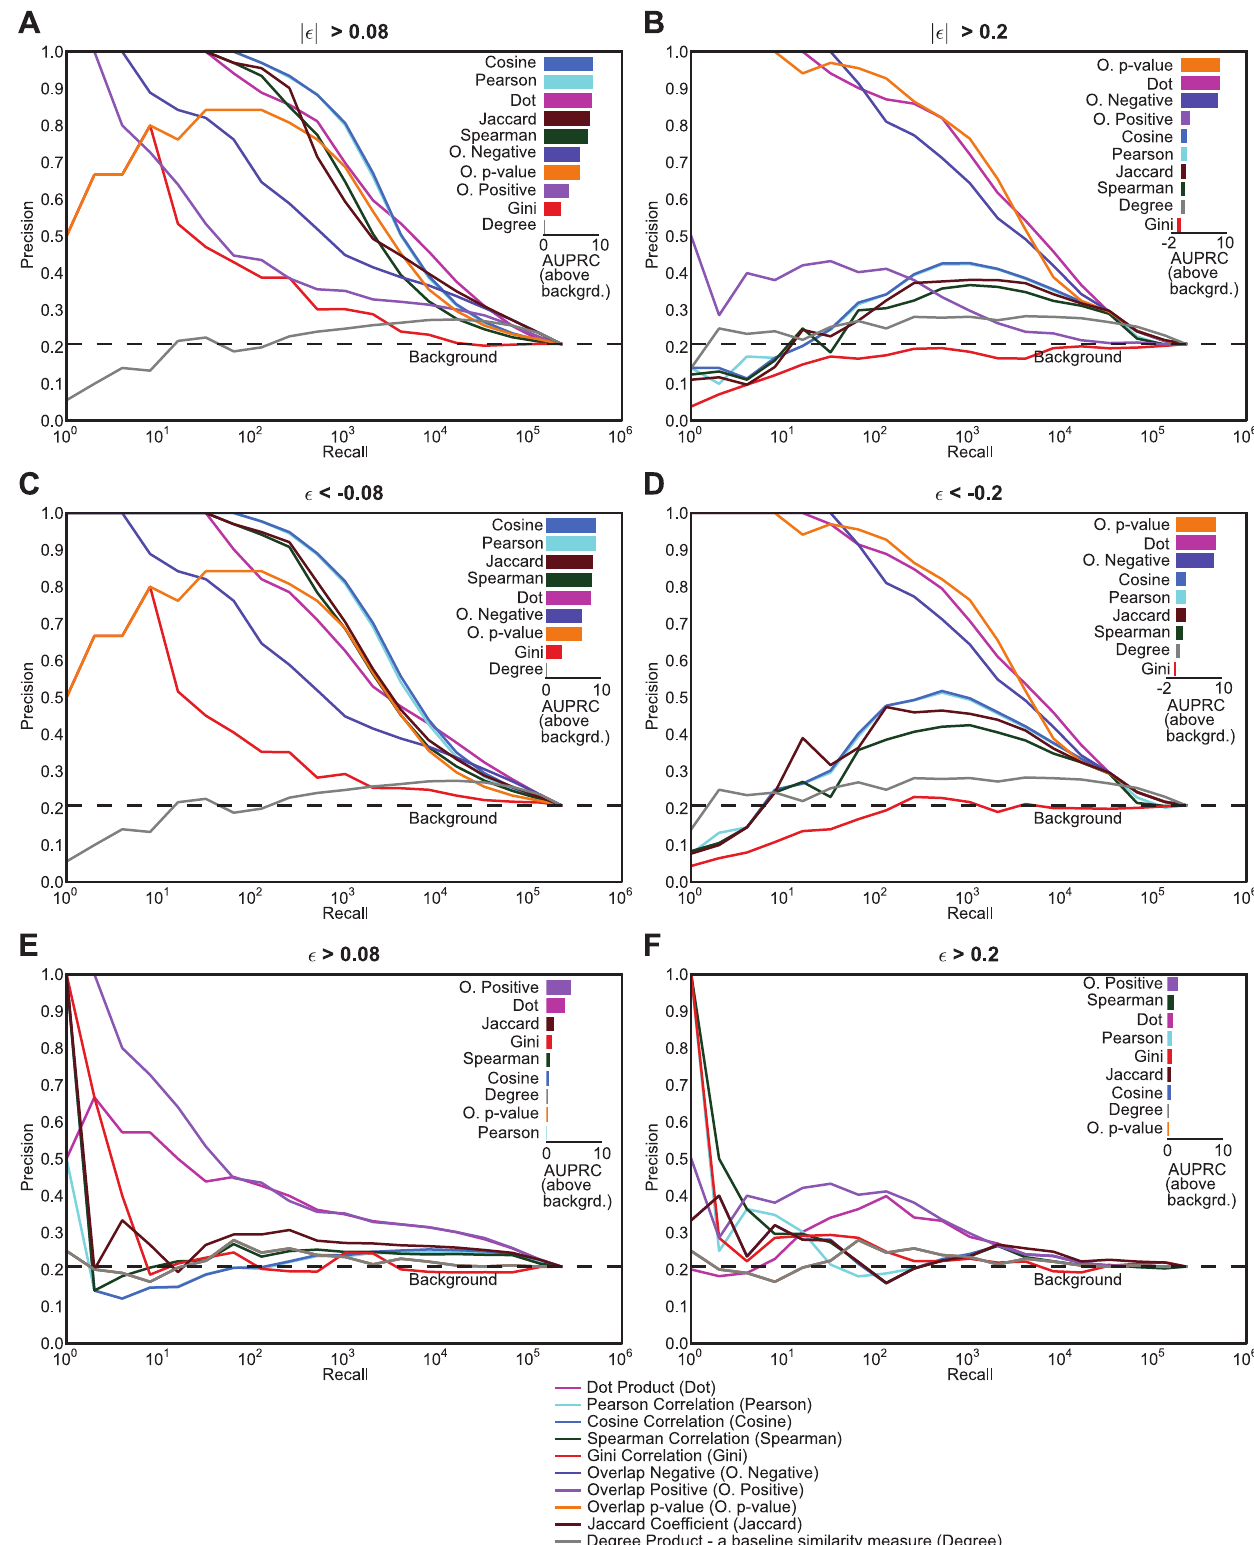
Figure 3. Role of thresholding genetic interaction data in the performance of similarity measures. The precision-recall plots were compared on the query side of the S. cerevisiae genetic interaction data at several thresholds (A) e ,2 0.08 - only negative genetic interactions at intermediate threshold, (B) e ,2 0.2 - only negative genetic interactions at a stringent threshold, (C) e . 0.08 - only positive genetic interactions at an intermediate threshold, (D) e . 0.2 - only positive genetic interactions at a stringent threshold, (E) | e | . 0.08, negative and positive interaction at an intermediate threshold, and (F) | e | . 0.2, negative and positive interaction at a stringent threshold. The bar plot on the upper right corner in each